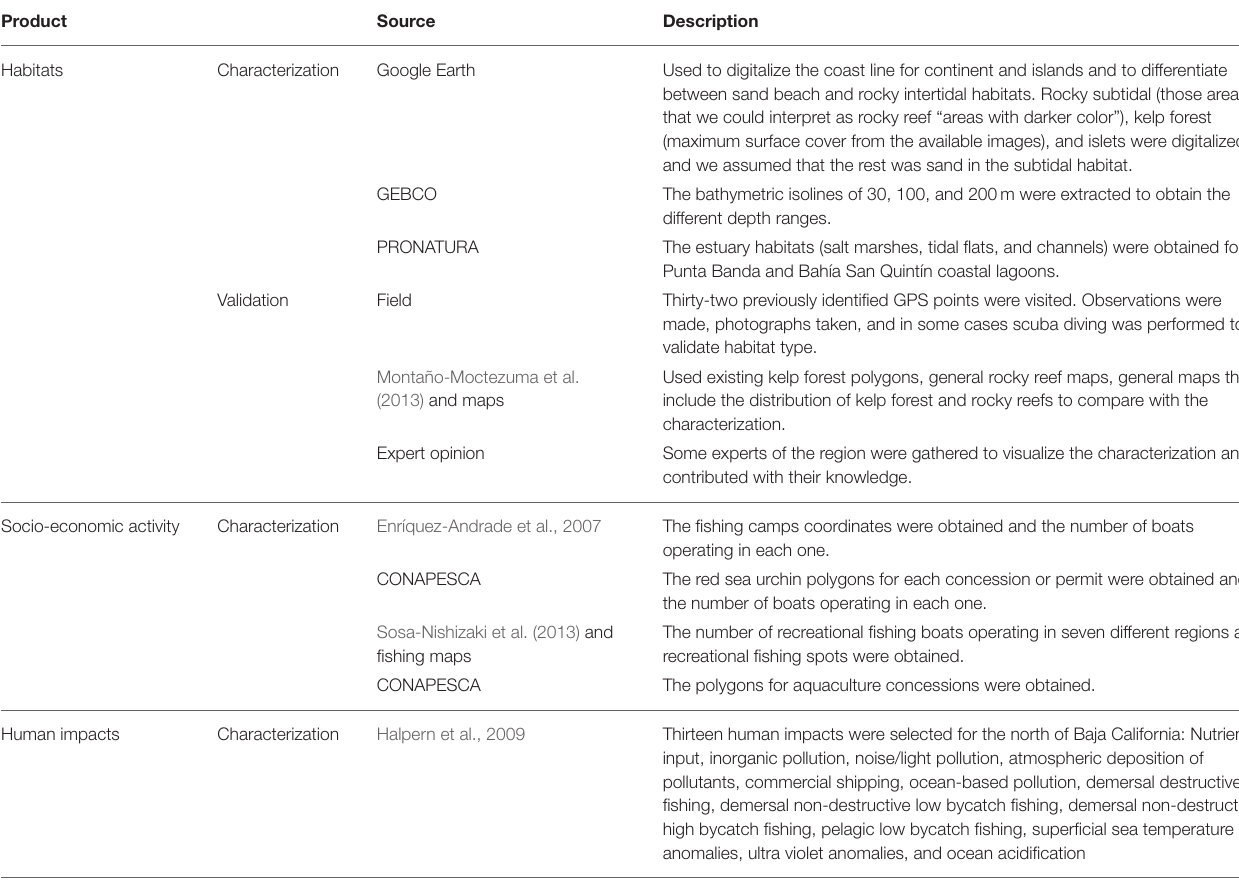
TABLE 3 | Data sources used to characterize key marine habitats, fishing and aquaculture activities, and human impacts on marine ecosystems for the MPRC1 in Baja California, Mexico.